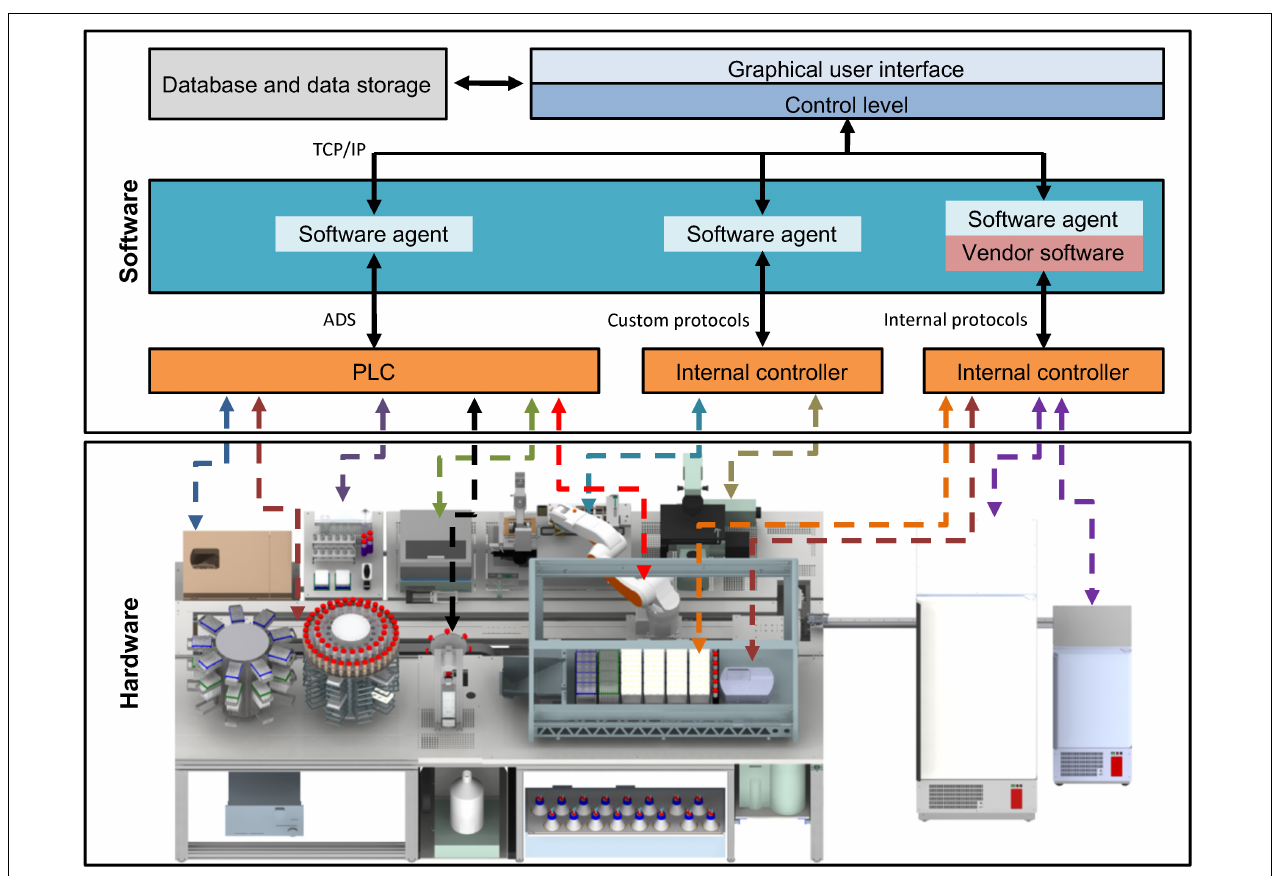
FIGURE 3 | Functional interconnection of hard- and software. All hardware devices of the StemCellFactory are functionally embedded in a control software system (upper box). The lower box displays the diverse hardware, which is controlled by a variety of different controllers and interfaces. The centrifuge, the robotic arm and the plate reader communicate using PLC/ADS systems. Other hardware such as the LHU, incubators or the microscope use other internal control systems. The software system comprises an integration framework, which serves as middleware and employs software agents to link in the different hardware components. Consequently, all connections merge in one control system by using standard TCP/IP protocols. The control system is linked to a database. PLC, Programmable Logic Controller, ADS, Accelerator Driven System, TCP/IP, Transmission Control Protocol/Internet Protocol, LHU, Liquid handling